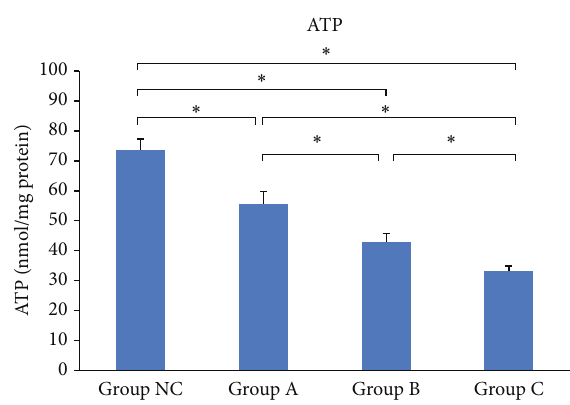
Figure 3: Effects of simvastatin on ATP levels in MIN6 cells. ∗ 𝑃 < 0.05